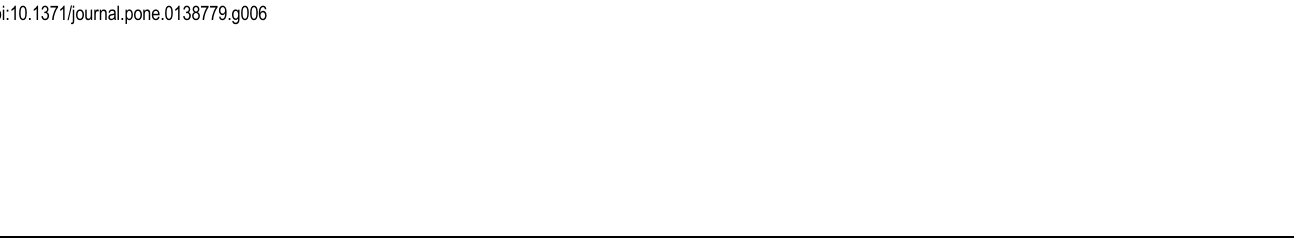
PLOS ONE | DOI:10.1371/journal.pone.0138779 October 21,